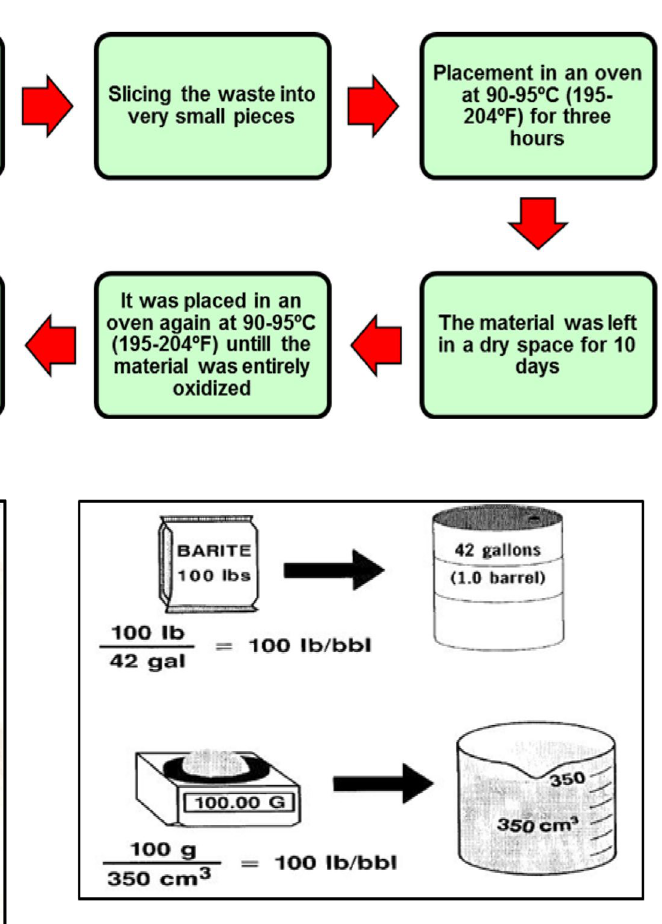
Fig. 8 Pilot testing equivalents (Amoco Production Company